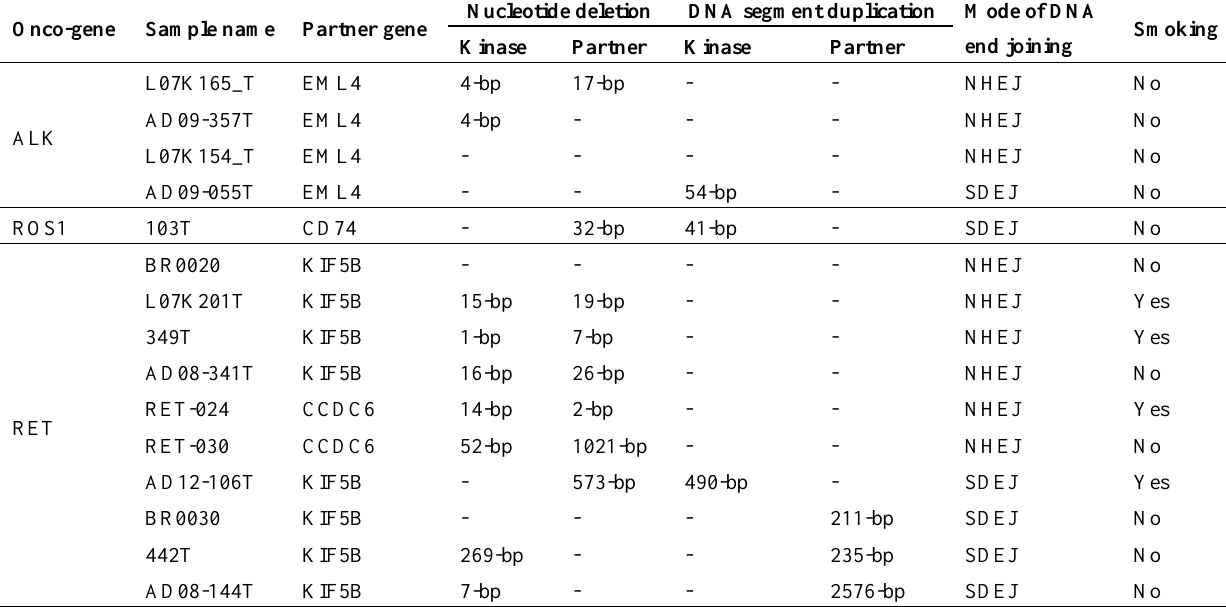
Table 1. Structure of breakpoint junctions for ALK , ROS1 , and RET reciprocal fusions in lung adenocarcinoma.